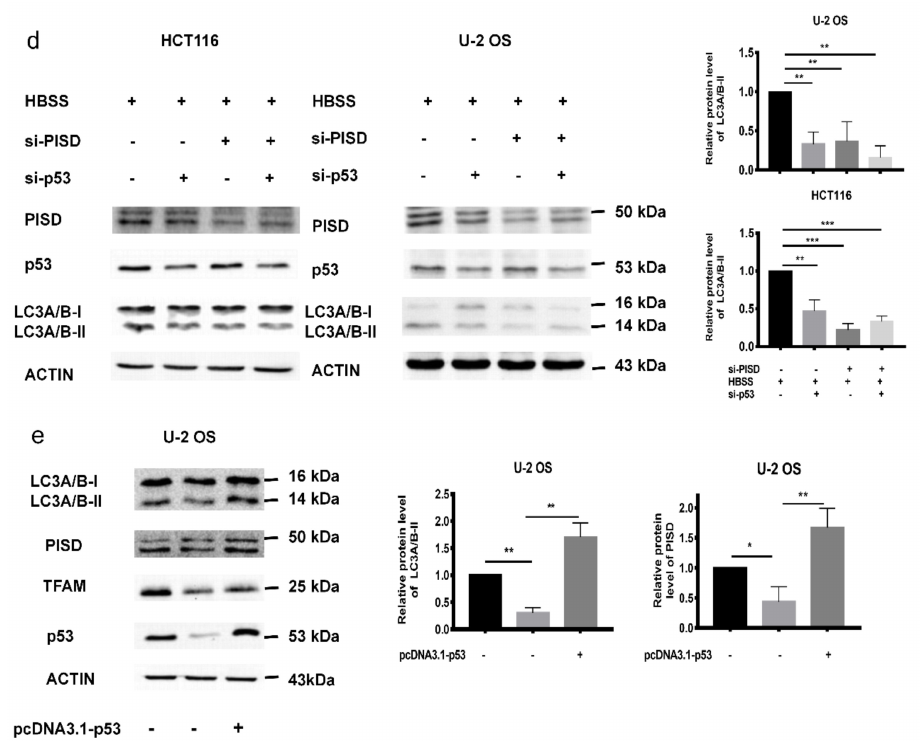
Figure 4. The inhibition of p53 and PISD impairs autophagy. ( a ) Protein levels of p53 and LC3-II in HCT116 or HCT116 p53 - / - cells. ( b ) Protein levels of LC3-II in HCT116 p53 - / - cells after treatment with CQ (50 µ M) and HBSS for one and six hours, respectively. ( c ) Under HBSS treatment, the protein levels of LC3-II in HCT116 cells after downregulating PISD expression with siRNA. ( d ) Protein levels of LC3-II in HCT116 and U-2 OS cells after downregulating the expression of p53 or PISD. ( e ) The levels of LC3-II and PISD in TFAM knockdown cells after being transfected with the pcDNA3.1-p53 construct. Each independent experiment was repeated three times or more, and data are presented as the mean ± SD. * p < 0.05, ** p < 0.01, *** p <